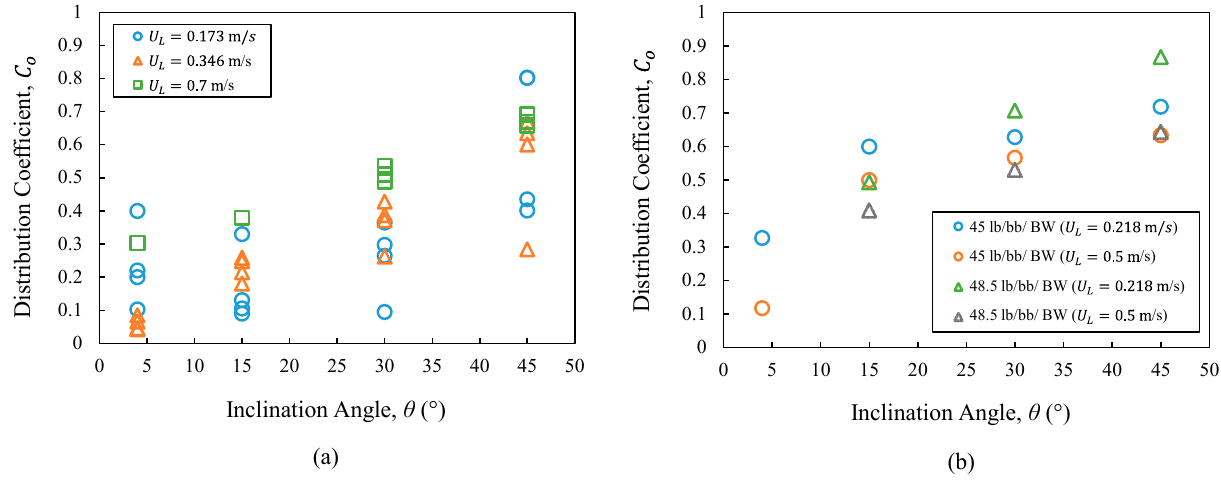
Figure 16. C o against the inclination angles. ( a ) Water; ( b ) Bingham plastic Figure 16. (cid:1829) (cid:3042) against the inclination angles. ( a ) Water; ( b ) Bingham plastic fluid. The general increasing trend of (cid:1829) with wellbore inclination is the result of (cid:1847) in- (cid:3042) (cid:3031) creasing more rapidly than (cid:1847) as (cid:2016) increases. (cid:1847) is measured under static fluid condi- (cid:3021) (cid:3031) tions; in a near-vertical wellbore, a Taylor bubble’s shape is relatively concentric, thus minimizing (cid:1847) (because it is hydrodynamically inefficient). As wellbore inclination de- (cid:3031) parts from vertical, buoyancy forces lateral to the bubble increasingly deform its shape to make the bubble is more hydrodynamically efficient, resulting in significantly higher (cid:1847) (cid:3031) values. (cid:1847) , on the other hand, is the translational velocity of a Taylor bubble that, because (cid:3021) of countercurrent flow, is always in a non-concentric (and, thus, a hydrodynamically effi- cient) shape, regardless of the flow conduit’s inclination for all our experiments. Hence, a progressively increasing (cid:2016) drives greater increases in (cid:1847) measured under static condi- (cid:3031) tions (see Figure 9) than (cid:1847) measured under constant (cid:1847) conditions (see Figure 14). (cid:3021) (cid:3013)